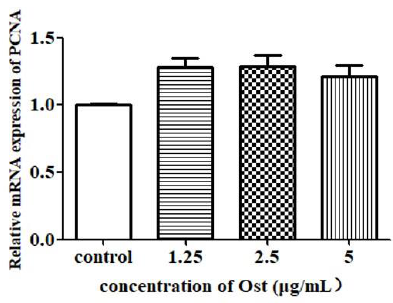
Figure 5. E ff ect of Ost on PCNA mRNA expression in granulosa cells. qRT-PCR was performed and 2 −(cid:52)(cid:52) Ct method was used for analysis. Data were expressed as Mean ± Figure 5. Effect of Ost on PCNA mRNA expression in granulosa cells. qRT-PCR was performed and 2 − △△ Ct method was used for analysis. Data were expressed as Mean ± SEM. Figure 5. Effect of Ost on PCNA mRNA expression in granulosa cells. qRT-PCR was performed and 2 − △△ Ct method was used for analysis. Data were expressed as Mean ± SEM. Figure 5. Effect of Ost on PCNA mRNA expression in granulosa cells. qRT-PCR was performed and 2 − △△ Ct method was used for analysis. Data were expressed as Mean ± SEM.